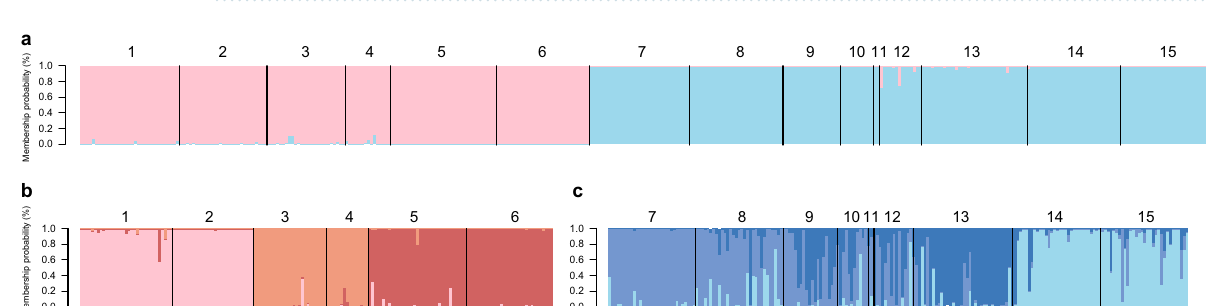
Figure 2. Variation of Weir and Cockerham 120 estimation of F IS ( f ) and F ST ( θ ) for each of the twelve microsatellite markers and across loci in Gongolaria barbata sampled in the Ionian, Adriatic and Black Seas ( a and b , respectively). The variation of Weir and Cockerham 120 estimation of F IS ( f ) and F ST ( θ ) for the nine microsatellites used in the study within the Ionian and Adriatic Seas (in pink) and within the Black Sea (in blue) was also provided ( c and d , respectively). For each locus, 95% confidence intervals were obtained by jackknife over subsamples and by bootstrap over loci. The averaged f and θ across loci were computed based on nine microsatellite markers, i.e. removing the three markers shaded in grey. The horizontal dashed line represents the 0 value. This figure was created using the R software 107 .